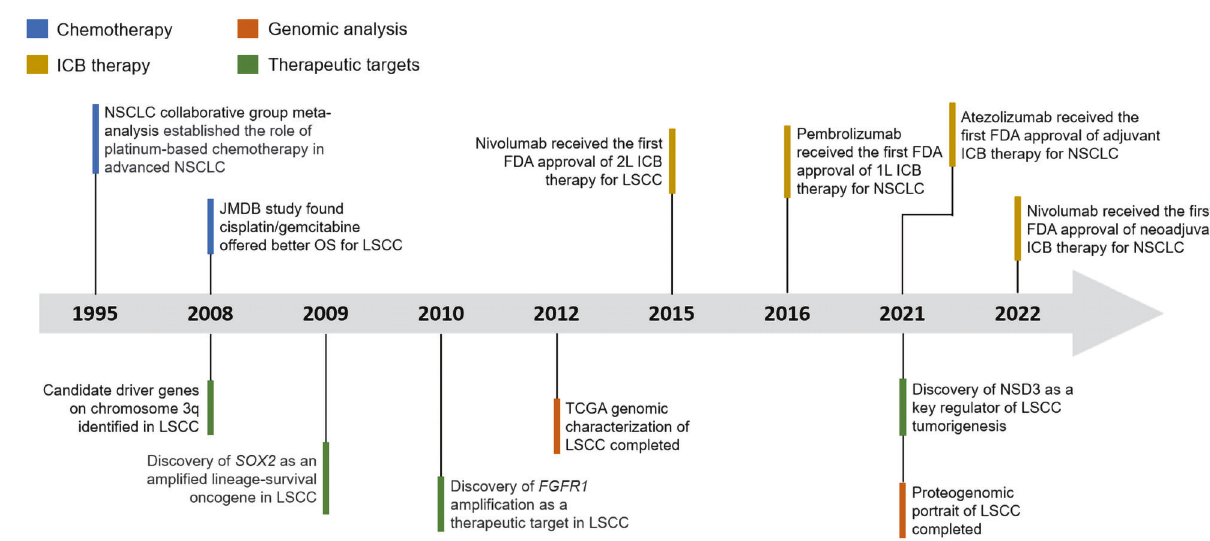
Fig. 1 Timeline illustrating the evolving treatment landscapes and research history of LSCC. Timeline highlights some of the pivotal clinical studies and discoveries that might change or have changed the management of LSCC. 1 L fi rst line, 2 L second line, ICB therapy immune- checkpoint blockade therapy, OS overall survival, TCGA The Cancer Genome